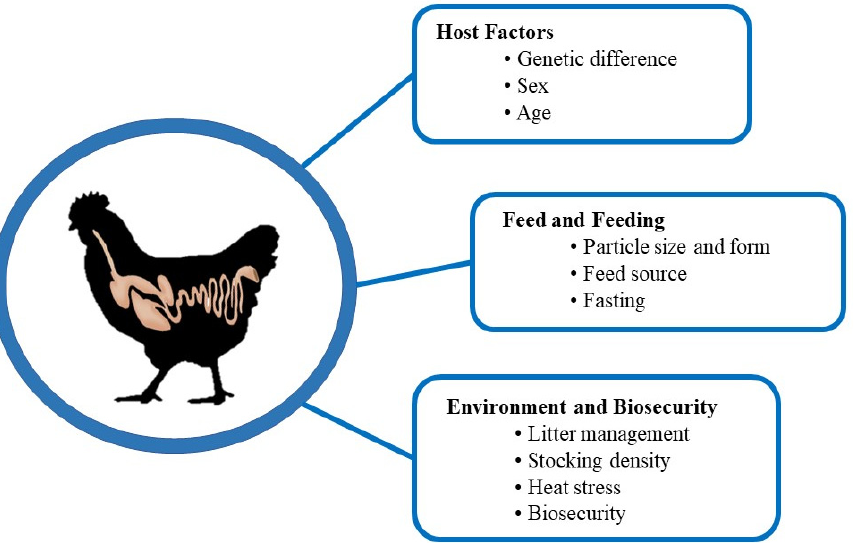
Figure 3. Factors affecting chicken gut health. A wide range of factors affecting chicken gut health can be categorized into three categories: host factors, feed and feeding factors, and environment and biosecurity factors. A single factor or many factor combinations can significantly affect the structure and physiological function of the chicken gut, altering the gut health and performance.